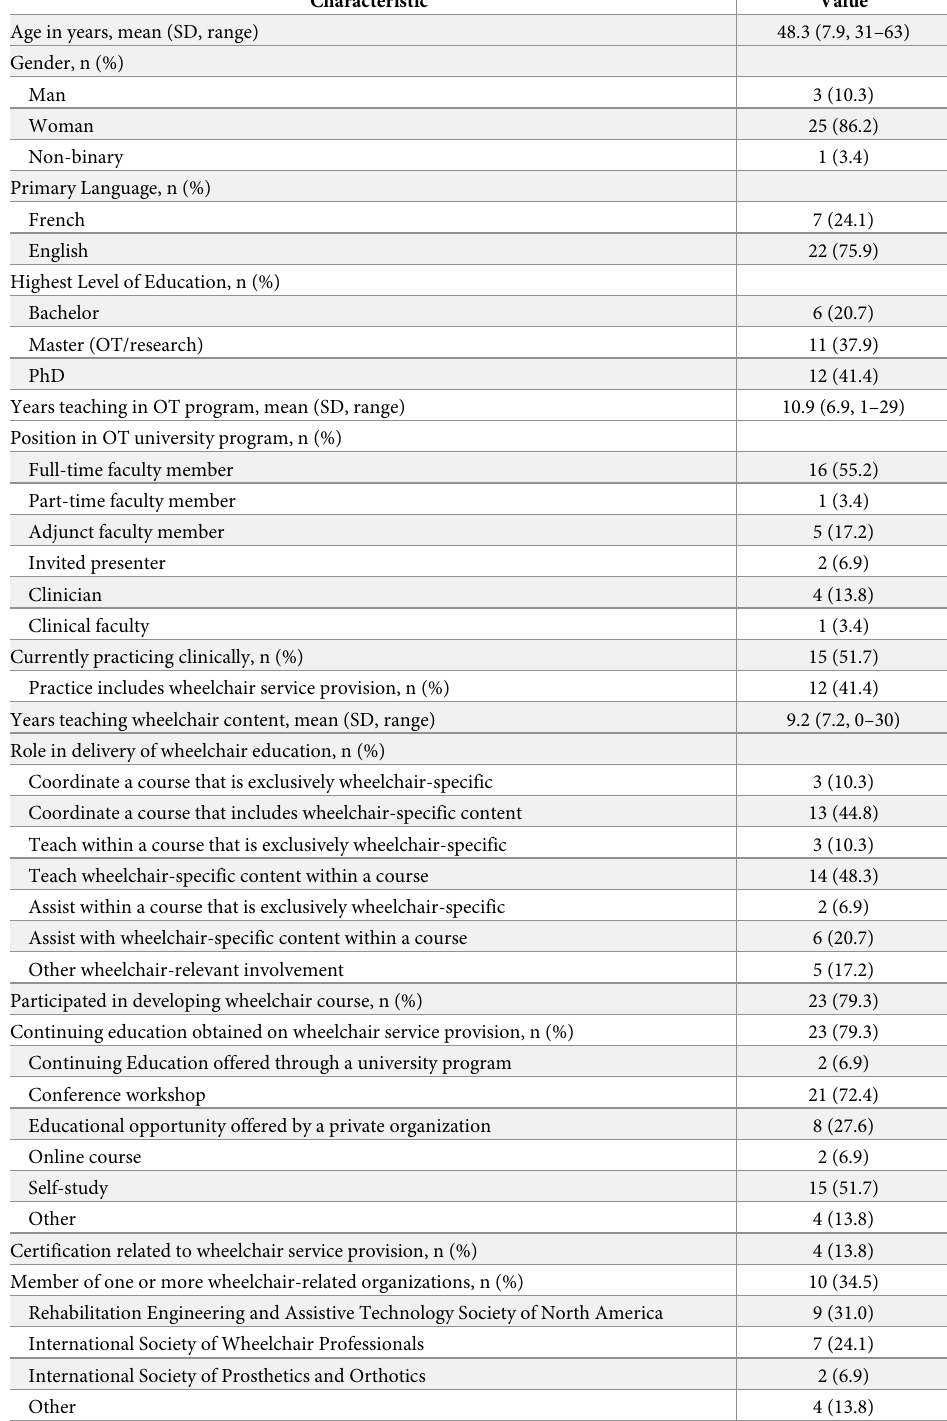
Table 1. Participants’ sociodemographic